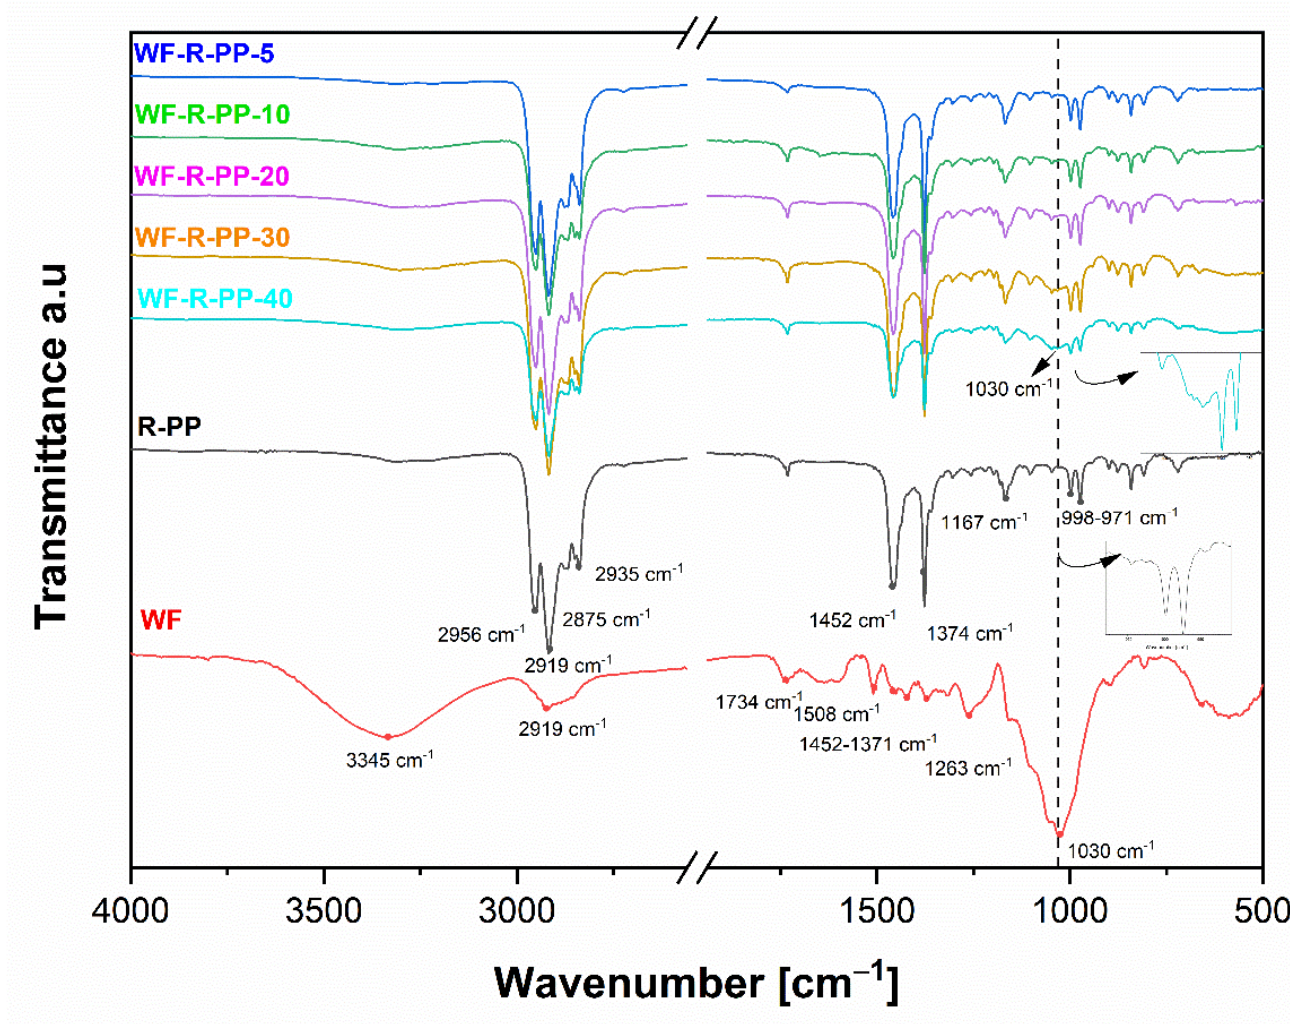
Figure 6. ATR-FTIR spectra of recycled PP, WF and wood fibre-polypropylene composites (WF-R-PP) injected moulded samples with different additions of WF content (from 5%:WF-R-PP-5 to 40%:WF-R-PP-40).